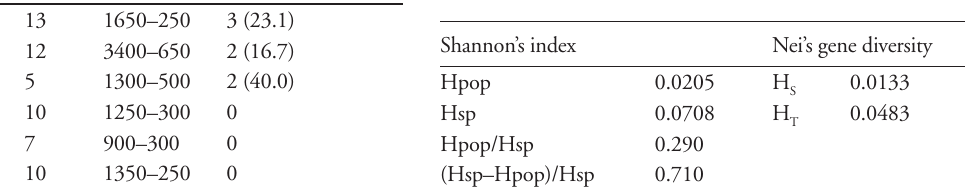
Table 5. Coefficients of genetic diversity and differentiation with- in and between populations of E. andevalensis. Hpop = average population genetic diversity, Hsp = total genetic diversity genetic diversity, Hpop/Hsp = partitioning of the diversity within popu- lations, (Hsp–Hpop)/Hsp = partitioning of the diversity between populations, H = mean expected heterozygosity within popula- S tions, H = expected heterozygosity in the total T